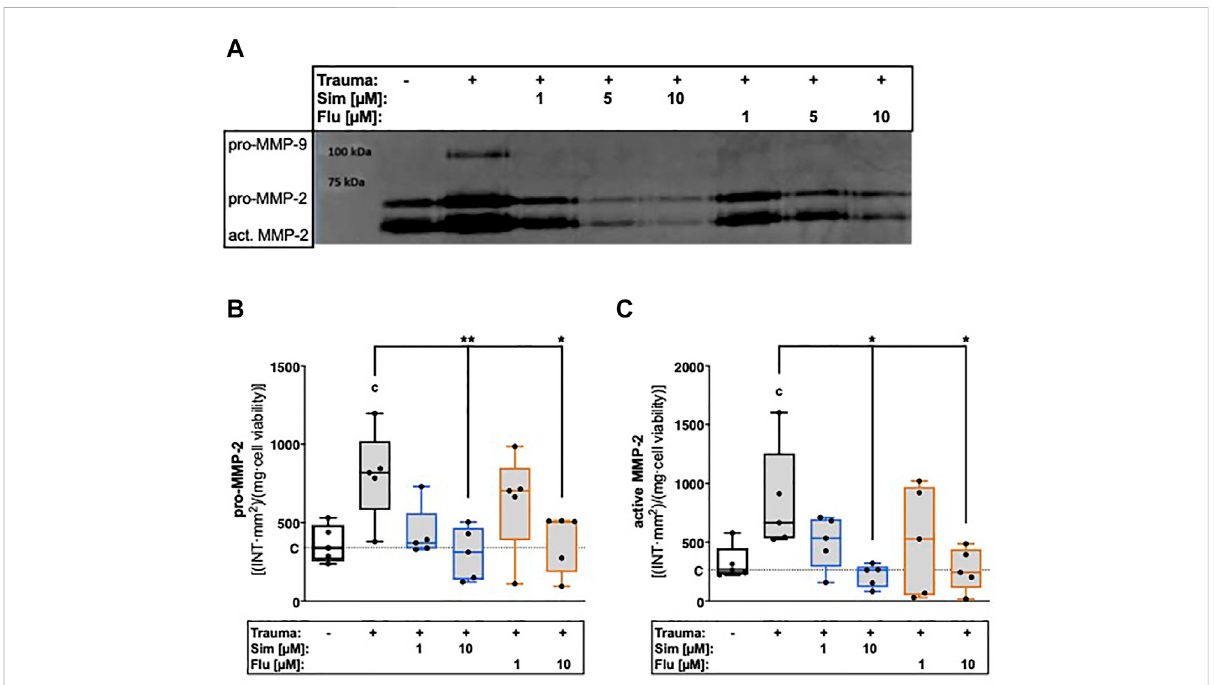
FIGURE 3 Effects of statin treatment on trauma-induced secretion and activity of gelatinases. Release of gelatinases MMP-2 and MMP-9 were measured by means of gelatin zymography as exemplarily demonstrated in (A) . Corresponding statistics of zymographically detectable amounts of (B) latent (pro-) MMP-2 and (C) active MMP-2. Signi fi cant differences between groups were depicted as [versus T] * = p < 0.05; ** = p < 0.01 [versus C] c = p < 0.05; n = 5. Blank box = unimpacted control (C), shaded boxes = traumatized cartilage explants